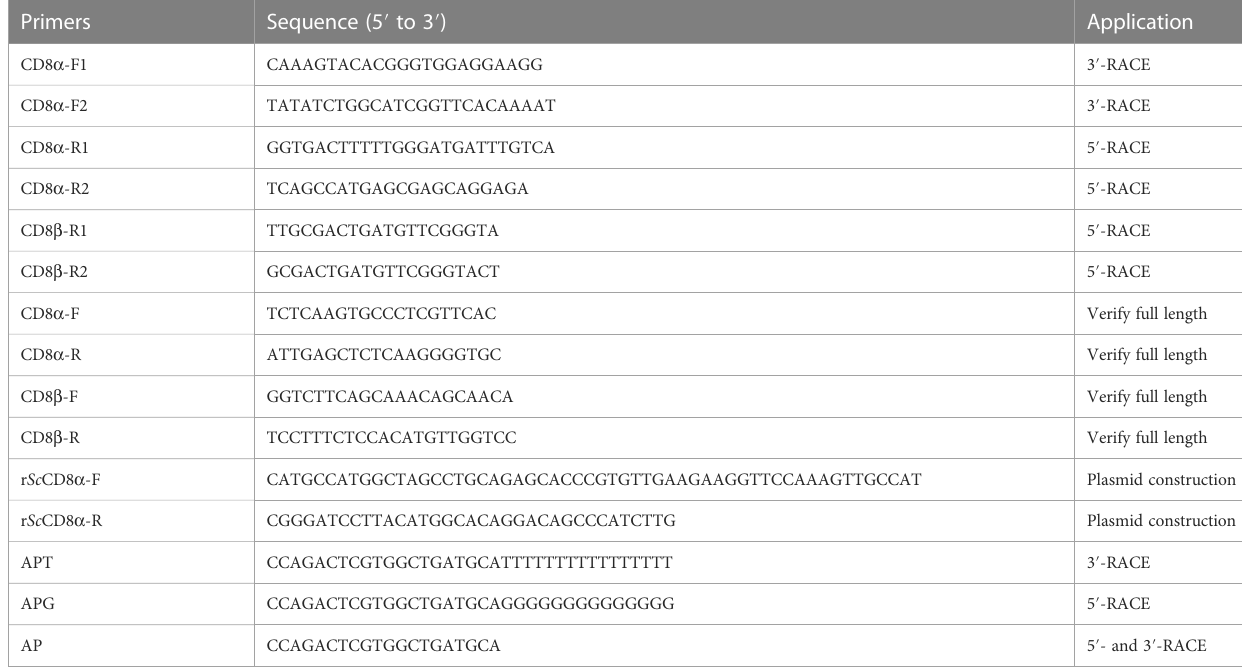
TABLE 1 Primers used in this